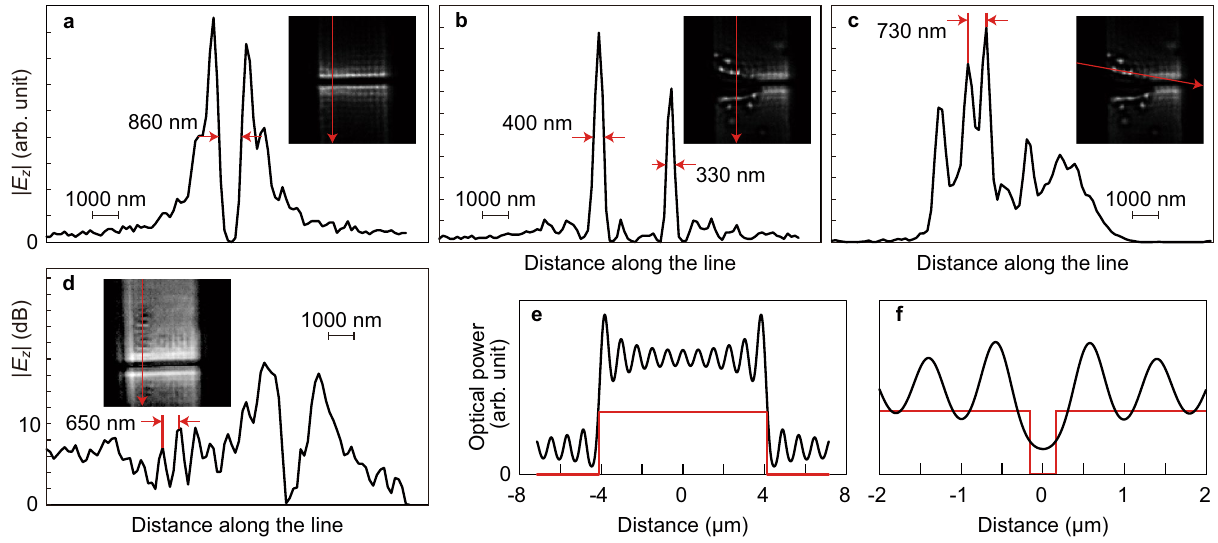
Figure 4. Line profiles of images for the electric field in the z direction E z . ( a ) Across the gap in pattern A. ( b ) Across the broken gap in pattern B. ( c ) Along the row of bright spots in pattern B. ( d ) Over the arrays of synthesized dots in pattern C. Optical power distributions at the DBR interface, simulated with the light reflected at the electrode patterns taken into account, across the electrode ( e ) and gap ( f